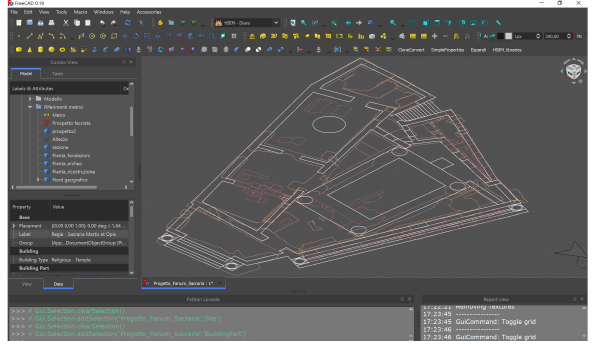
Figure 3 . 2D vectorial data imported inside FreeCAD: archaeological and reconstruction (white) plans.